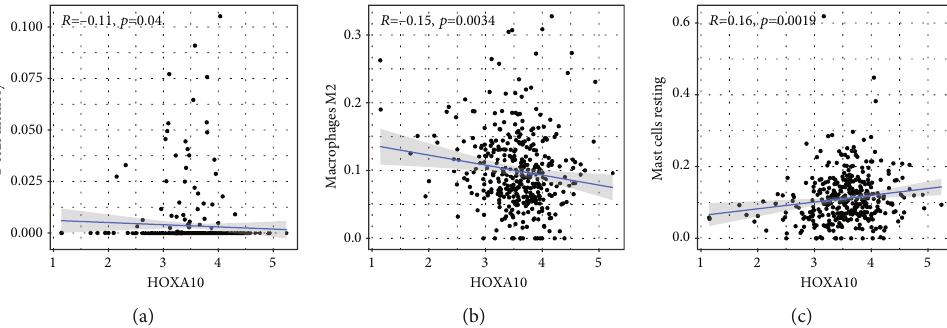
Figure 12: (a – c) Scatter plot presenting the association of 3 types of TIC proportion with the expression of